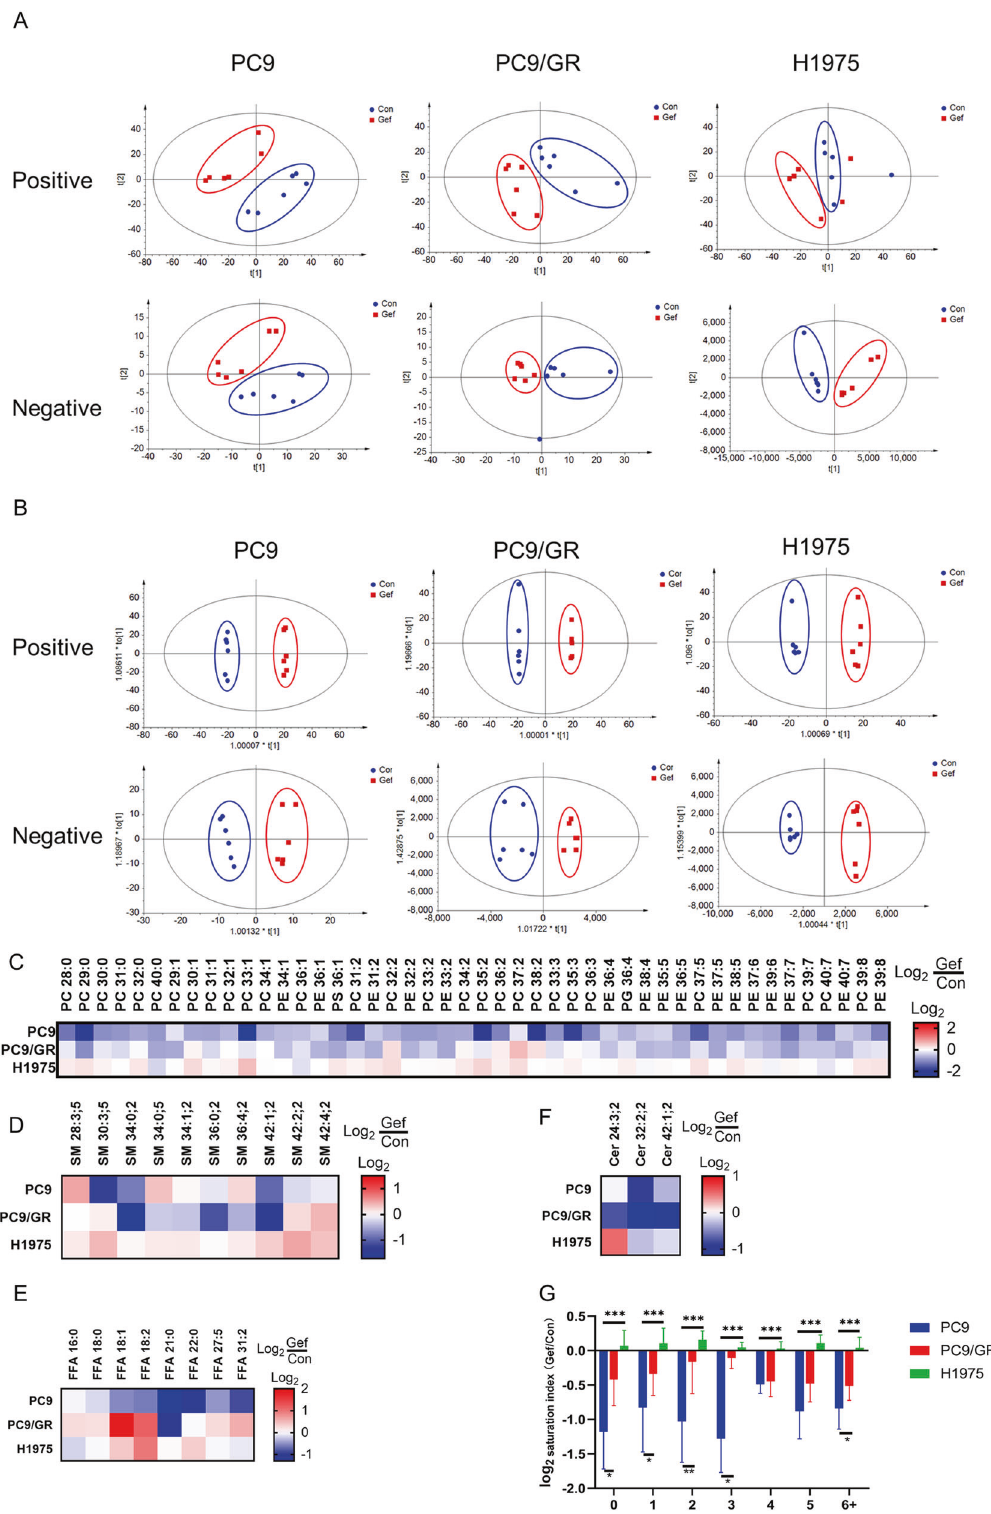
Fig. 2 De novo lipogenesis in ge fi tinib-sensitive PC9 cells is inhibited by ge fi tinib, while remains activate in PC9/GR and H1975 cells. A Lipidomic analysis on control and Gef group in positive and negative ion modes, respectively. PCA score plots of lipidomic pro fi les obtained from LC-MS/MS. B OPLS-DA score plots of lipidomic pro fi les obtained from LC-MS/MS. C – F Comparison of the changed lipids between control and Gef group. Heatmap shows the ratios of phospholipid species abundance in cells treated with and without ge fi tinib. Species are represented by the total number of fatty acid carbons and unsaturated carbons, which are linked by a colon. G Log 2 ratios of the changes in saturation index induced by ge fi tinib. The saturation index is derived from the sum of species with the same unsaturated level. Data are expressed as the mean ± SD ( n =